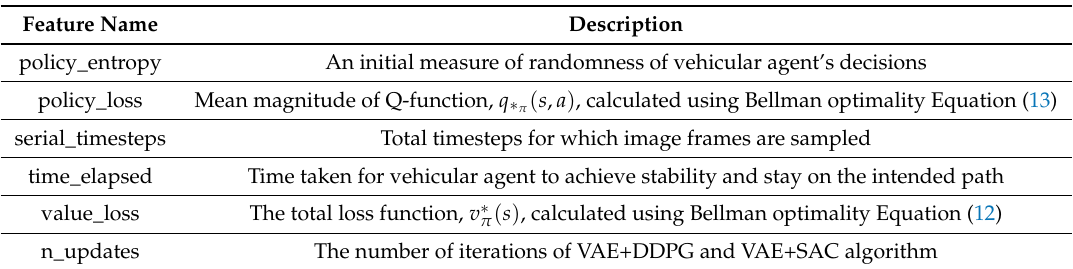
Table 2. Features considered in the simulation.